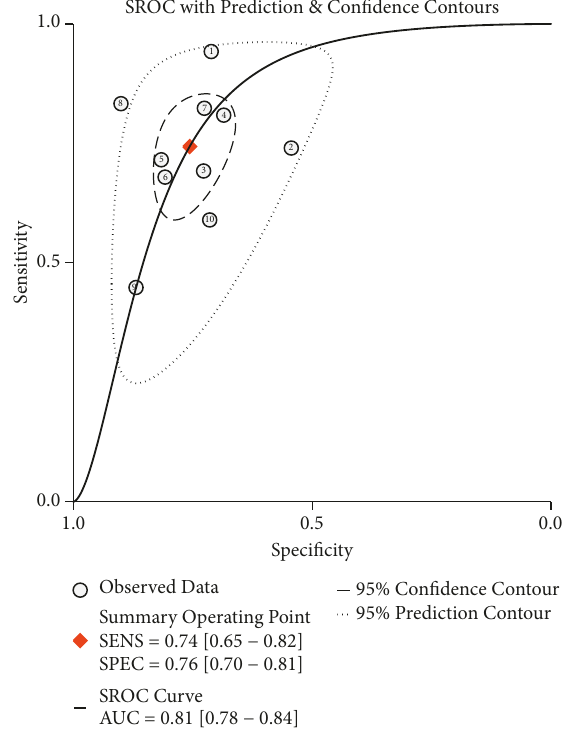
Figure 3: Summary receiver operating characteristic (SROC) curve of cirRNAs in the diagnosis of